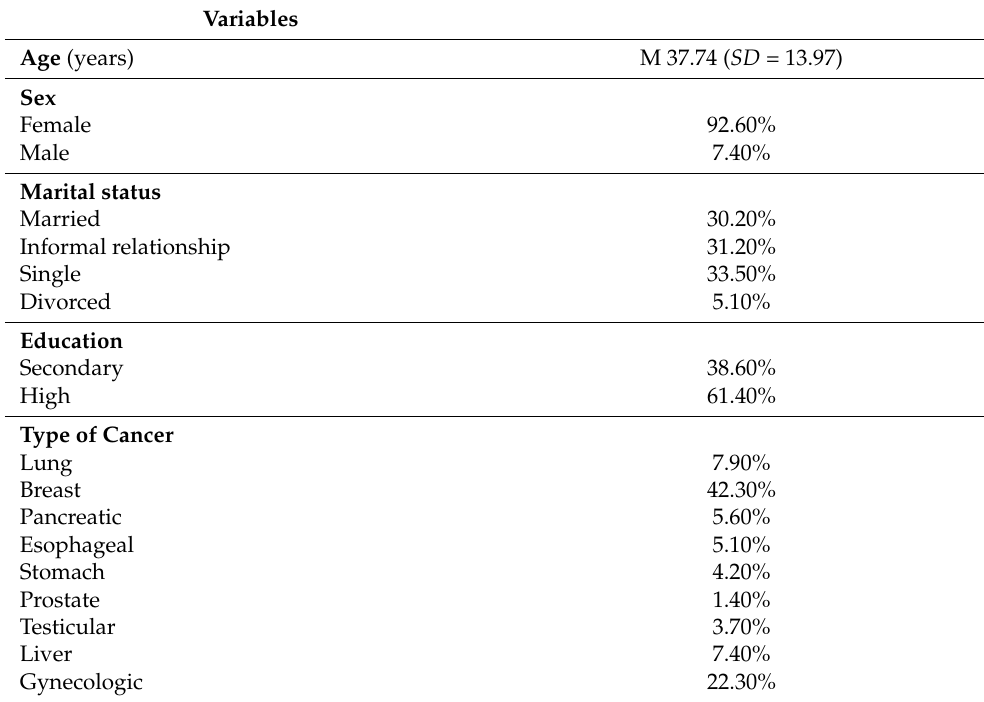
Table 1. Demographics, marital status, education, and type of cancer ( N =